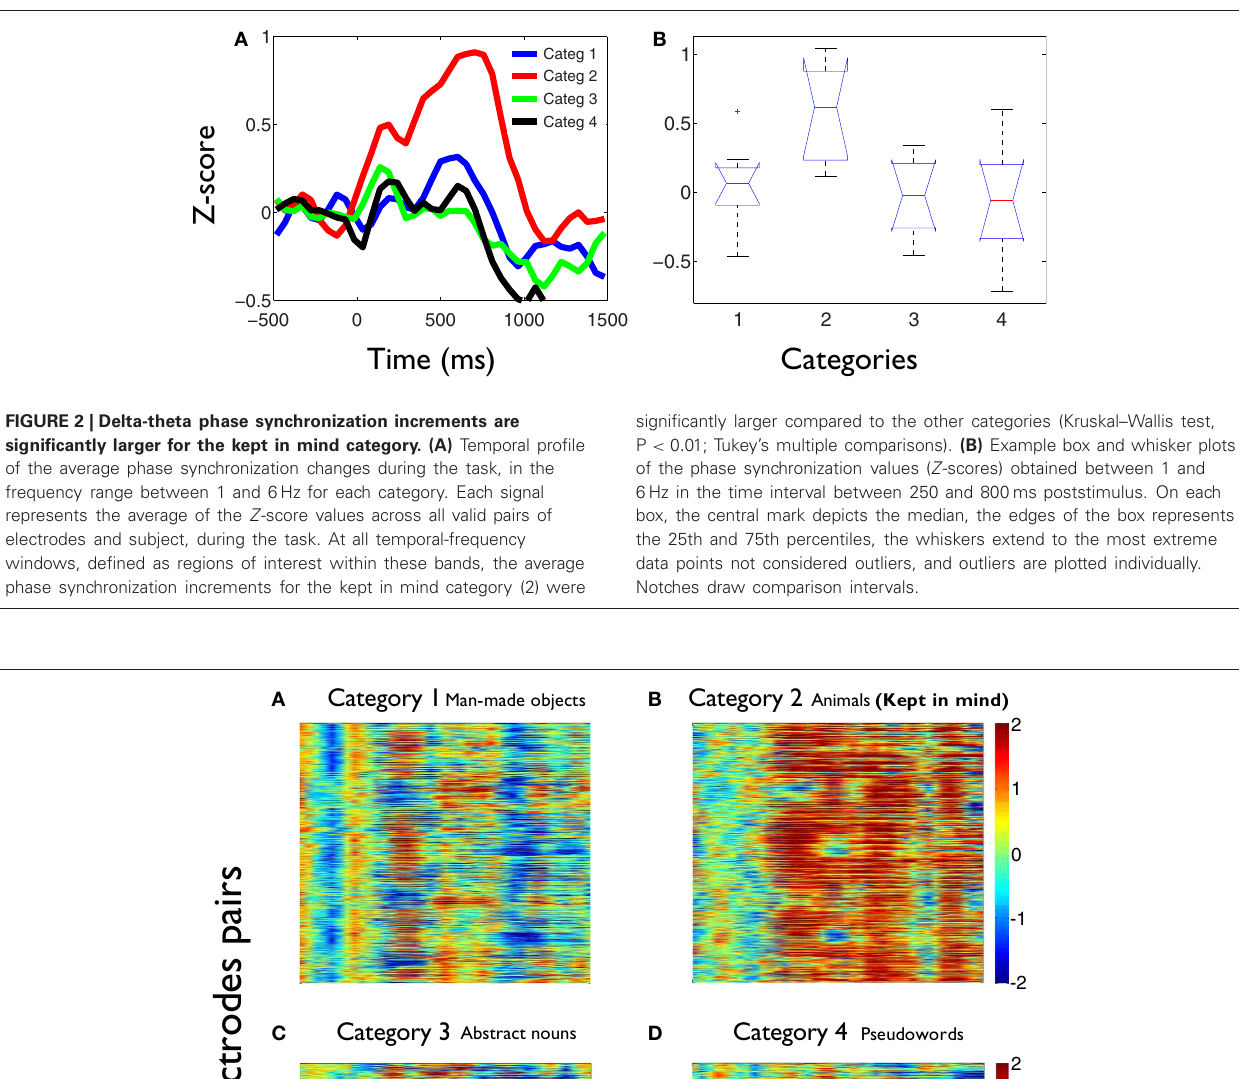
FIGURE 3 | Detecting relevant semantic information selectively synchronizes new electrode pairs during the task. Example plots of the phase synchronization changes at 4–6Hz occurred between all valid pairs of electrodes for each category during the task, in one subject. Categories (A–D) are ordered as in Figure 1 . (B) corresponds to the kept in mind category. Note that there are specific time windows where electrodes become synchronized across the task in each